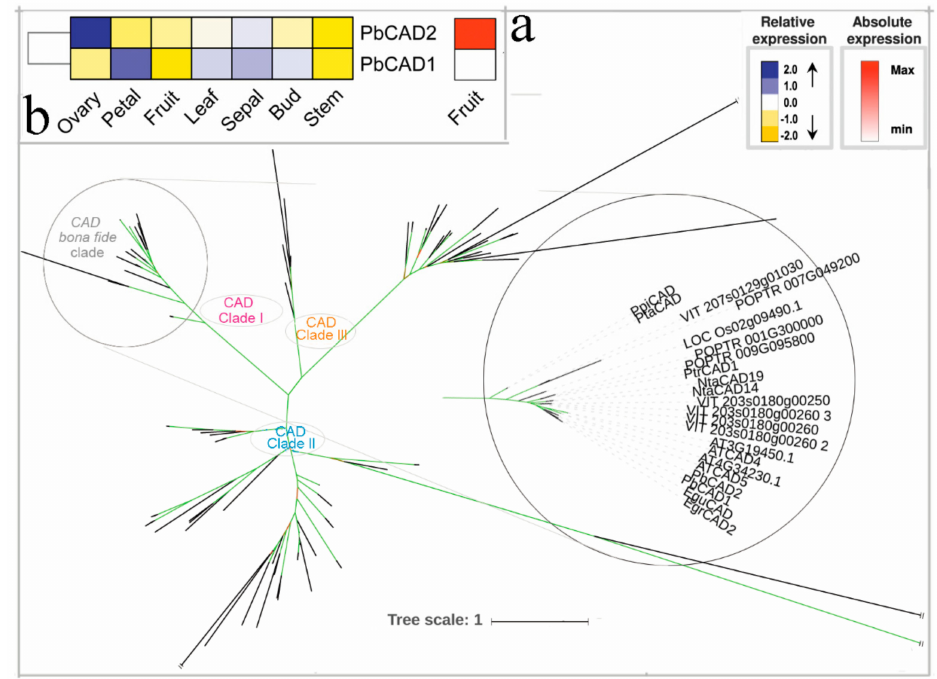
Figure 11. Phylogenetic tree and expression profiles of the CAD bona fide clade. ( a ) ML tree built with CAD bona fide enzymes from several species. ( b ) The expression profiles P. bretschneideri CAD bona fide genes. Subclade containing the bona fide genes is highlighted. The green color of the tree branches suggests strong node support (bootstrap support ≥ 95% and SH-aLRT ≥ 75%). The FPKM values of PbCAD genes in di ff erent tissues are indicated in Table S3. The gene accession number is indicated in Table S4, Figure S6. The tree scale is the number of amino acid substitution per